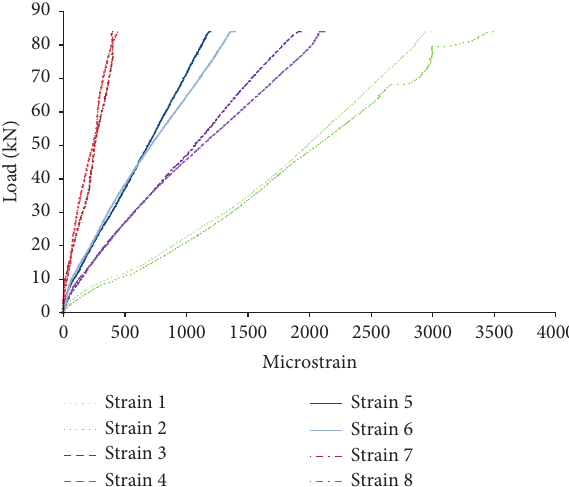
Figure 13: Ribbed bar-reinforced OPC pull-out load and steel strain relationship.